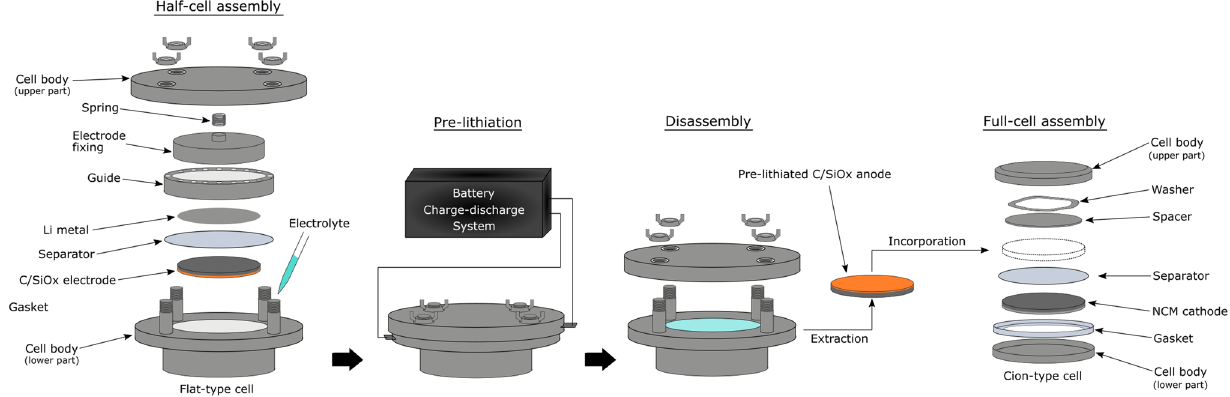
Figure 1. Pre-lithiation of the C/SiO x anode and Li(Ni 0.5 Co 0.2 Mn 0.3 )O 2 (NCM) + C/SiO x full-cell